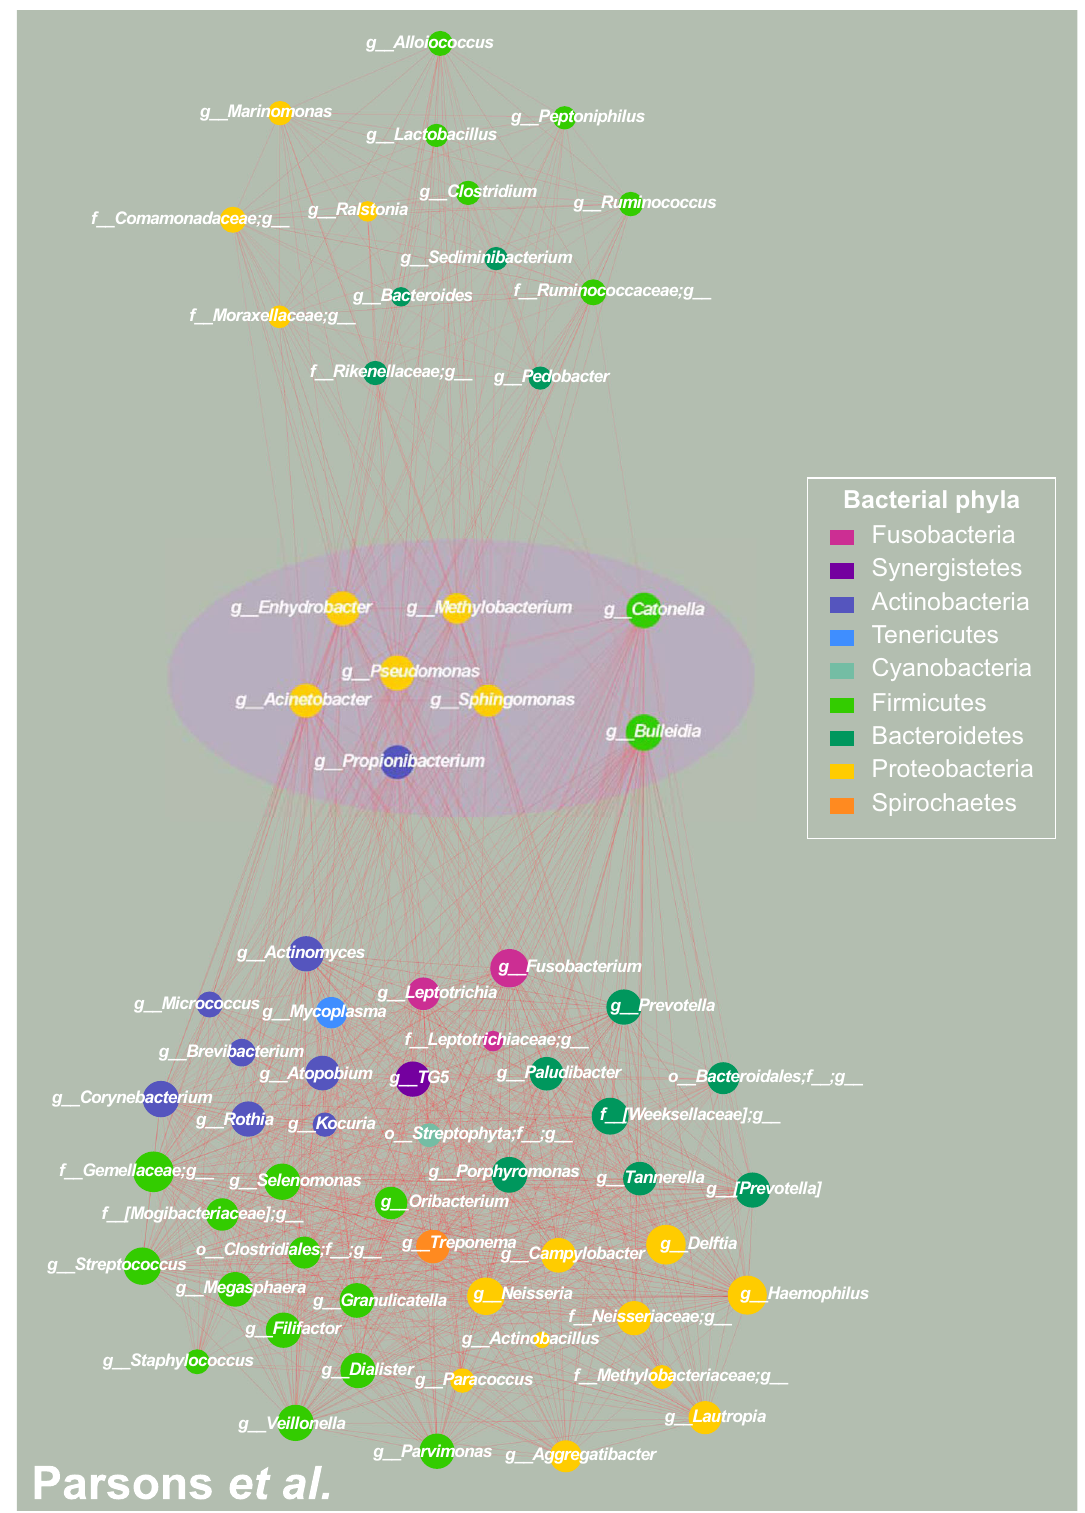
mucosa-associated microbiota in PPI-untreated H. pylori -nega- tive and -positive subjects. However, for the sake of clarity, we have to specify a difference: while in Paroni Sterbini ’ s dataset the with dyspepsia, this is not the case for Parsons ’ s